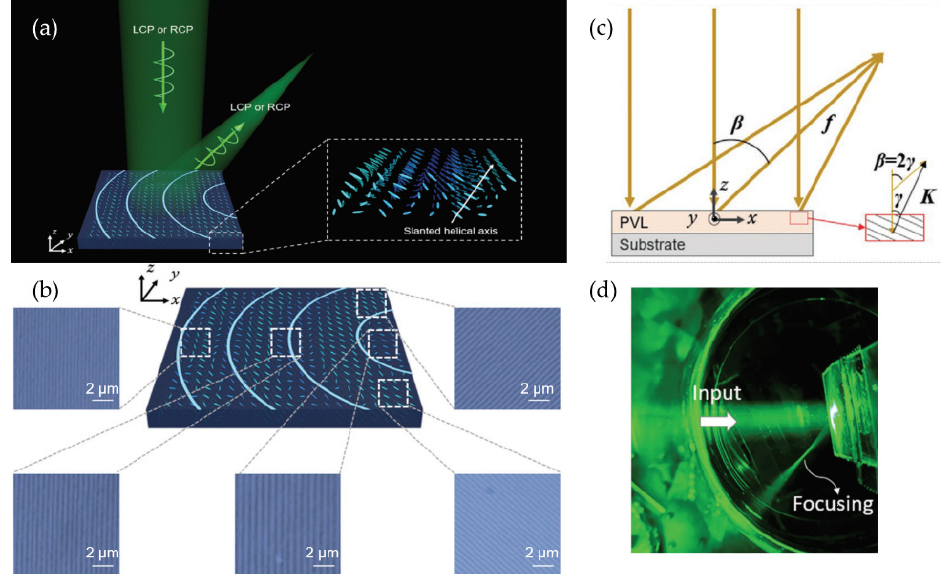
Figure 15. ( a ) Schematic diagram of the beam focus formed by a rPVL and the LC director configuration inside. ( b ) Polarizing optical microscope (POM) images of rPVL at three locations. ( c ) Schematic diagram showing the coordinates of the rPVL. ( d ) Sample immersed in a cylindrical container to observe the off-axis focusing behavior and diffraction angle [13]. Copyright 2020, WILEY - VCH.